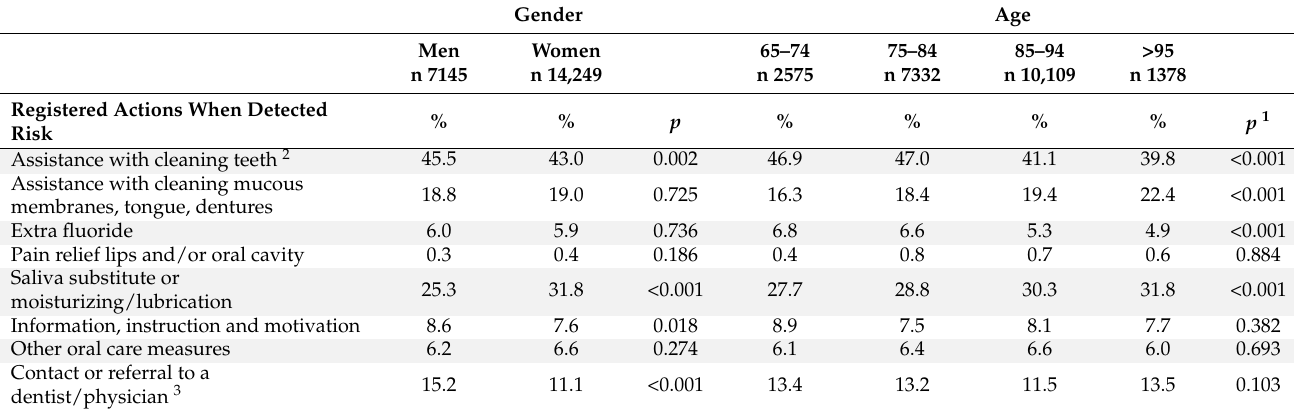
Table 4. Distribution (%), according to gender and age, of actions registered when risk (n = 21,394) was detected using ROAG-J. Fisher’s exact test (gender) and t -test (age) were used to analyse statistical differences shown with p -value.